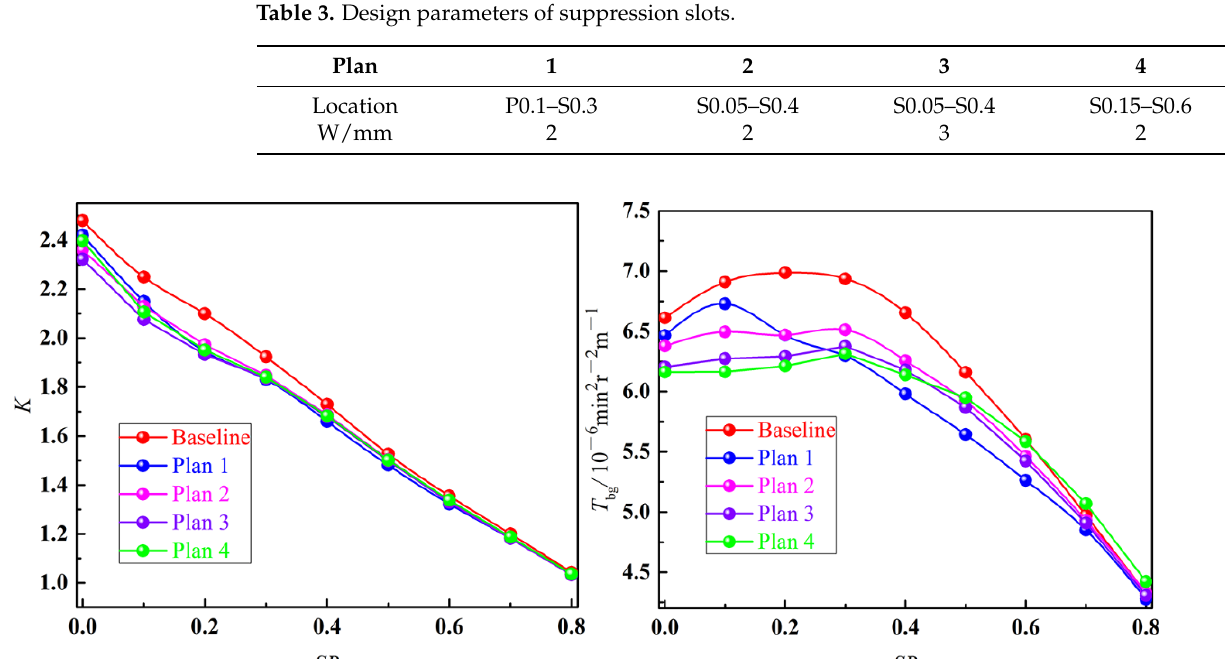
Figure 8. Comparison of time-averaged K and T bg with various suppression slots.